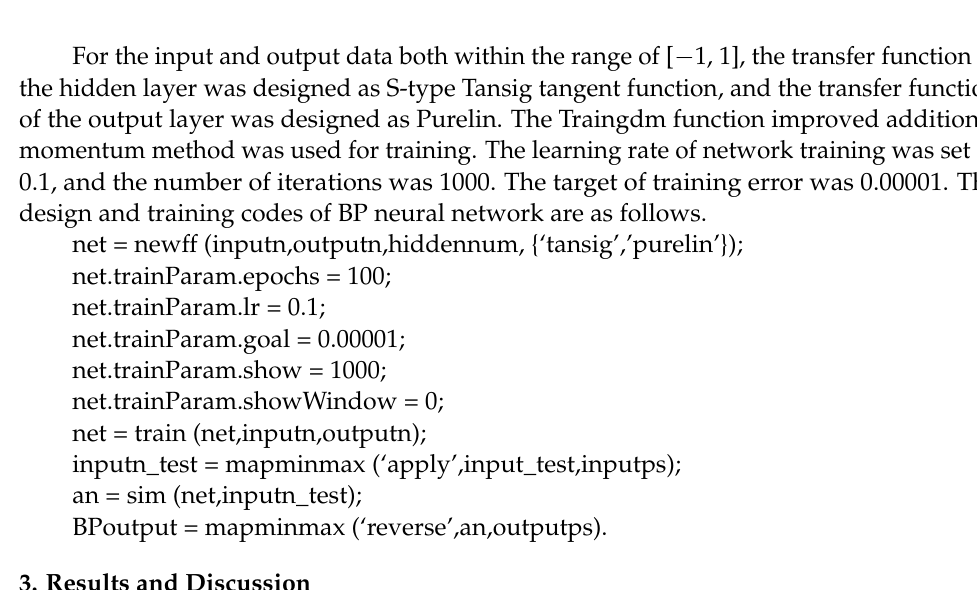
( a ) ( b ) ( c ) Figure 12. The influence of content and length of steel wool fiber on ice layer temperature. ( a ) 1 mm; ( b ) 3 mm; ( c ) 5 mm.